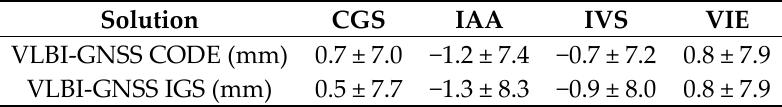
Table 1. VLBI-based ZTD differences with respect to GNSS solutions